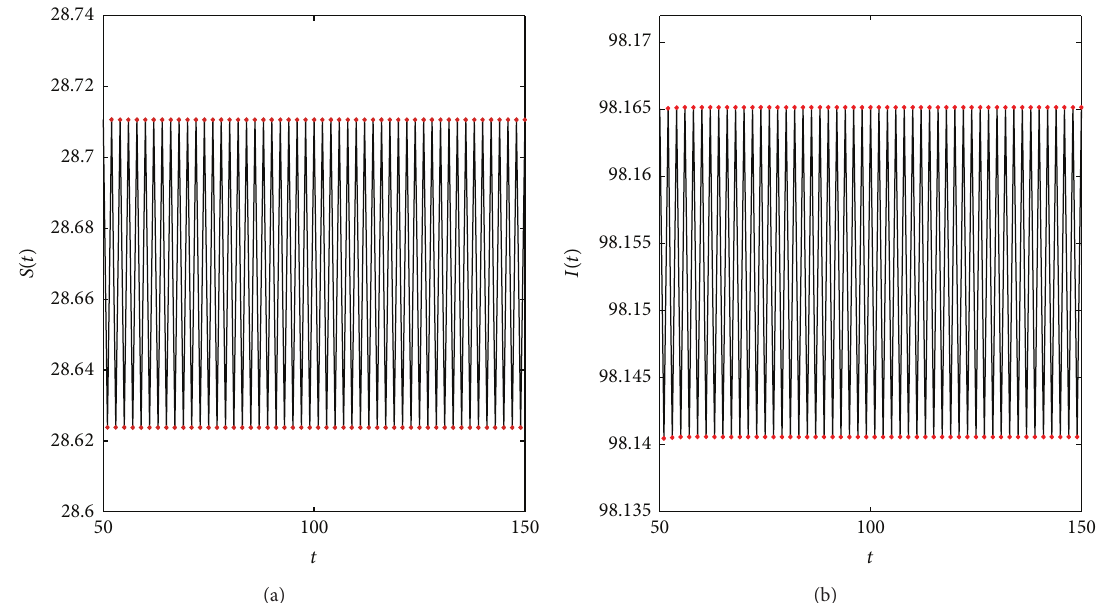
Figure 4: Dynamical behavior of system (2) with 𝛽(𝑡) = 0.005( sin 𝑡+2) , 𝜆(𝑡) = 10 , 𝛼(𝑡) = 0.01 , 𝜇(𝑡) = 0.1 , 𝛾(𝑡) = 0.1 , 𝜀(𝑡) = 0.8 , 𝜔 = 2𝑇 = 2𝜋 , and 𝜃 1 = 𝜃 2 = 0.01 . (a) Time series of 𝑆(𝑡) . (b) Time series of 𝐼(𝑡)